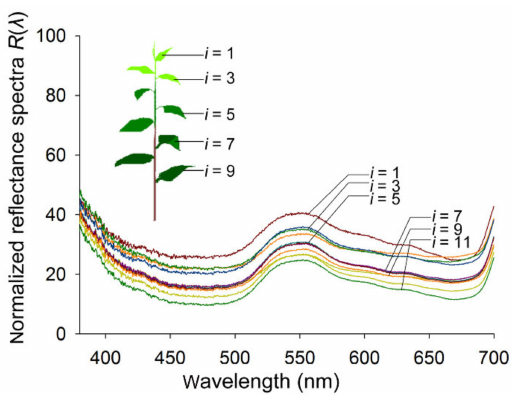
Figure 1. The normalized reflectance spectra R ( λ ) i of tea leaves: The inset diagram is of a tea shoot showing the tea foliage of di ff erent leaf ages, numbered with i ( i = 1–11) from the top to bottom. On